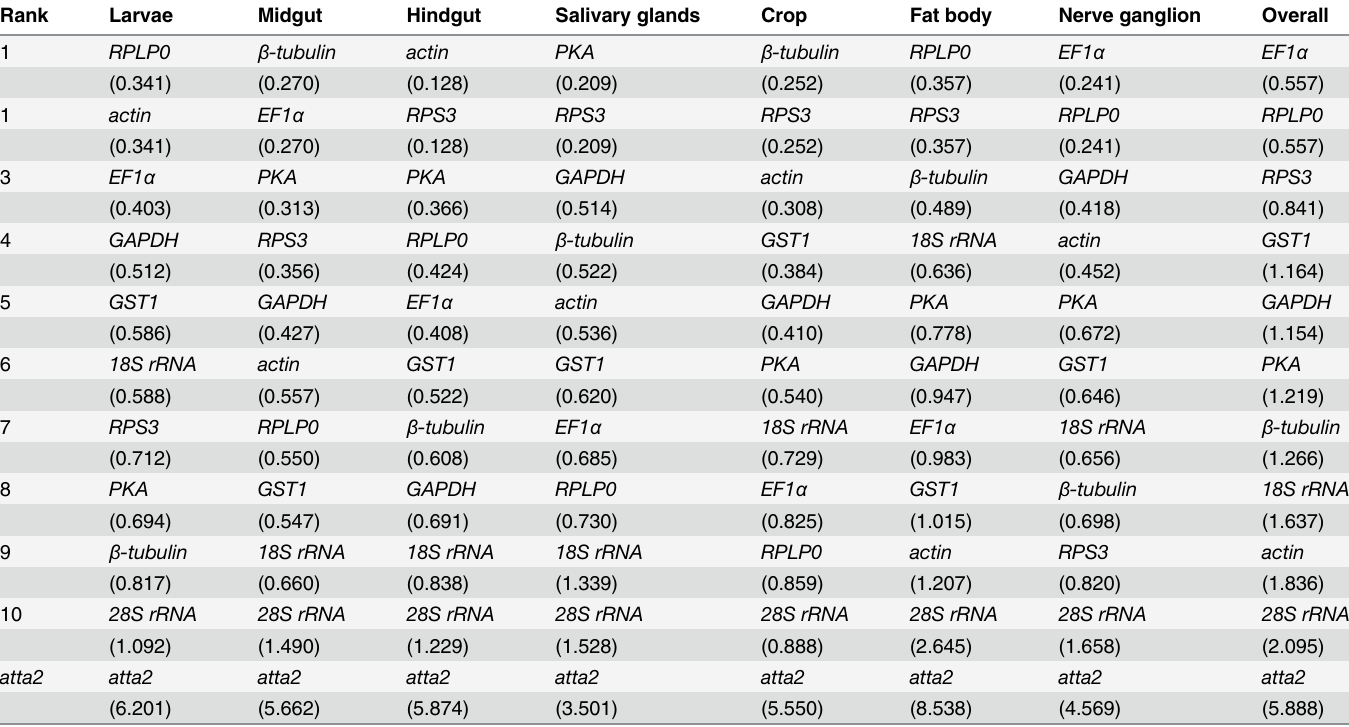
Table 3. GeNorm ranking of stability measures for candidate reference genes and attacin-2